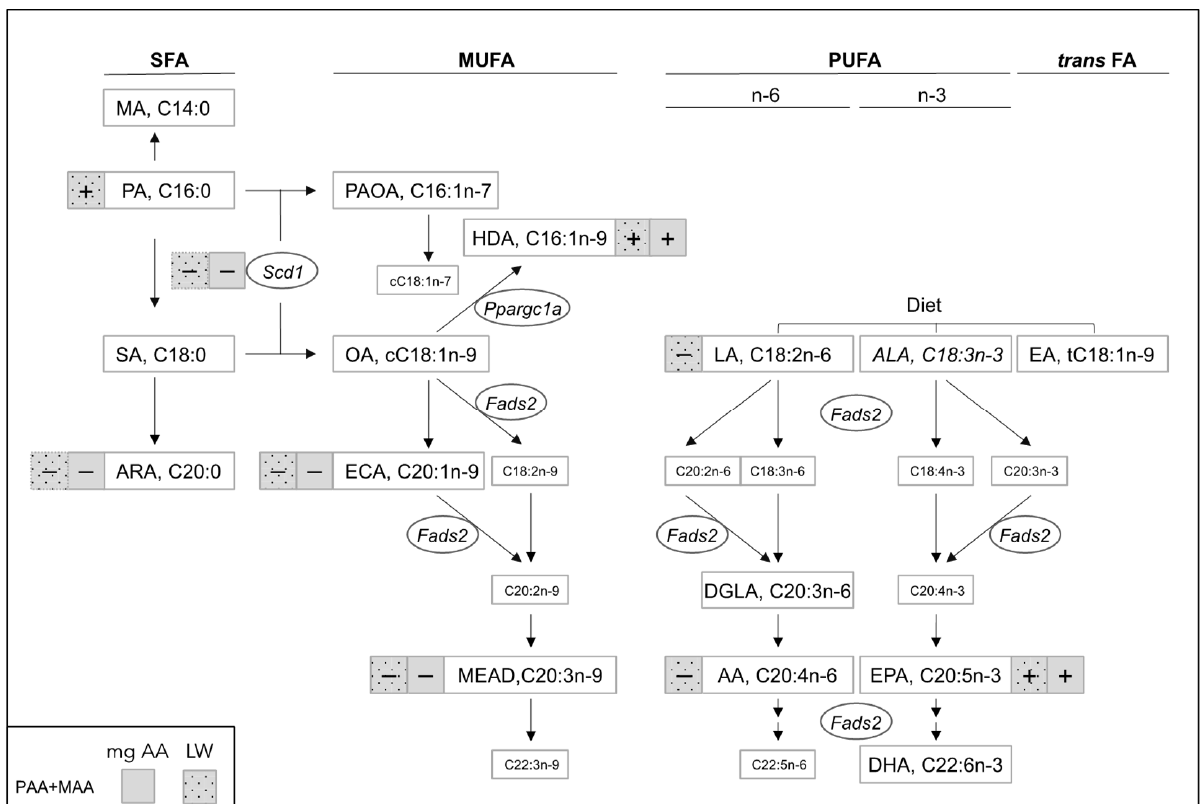
Figure 5. Correlations between milligrams of parental AA exposure or liver weight and offspring liver FA content. Diagram of SFA, MUFA, and PUFA biosynthesis pathways highlighting individual FA that showed significant ( p < 0.05) or borderline significant ( p < 0.1) correlations with both germline and germline + somatic PAA+MAA exposure (Pearson’s r). Large white boxes indicate the analyzed FA; FA in italics were not detectable. Squares with solid and dotted filling indicate significant and borderline significant correlations with AA exposure (grey) or liver weight (grey with black dots); “+” and “ − “ indicate positive and negative correlations, respectively; promoter methylation was analyzed on the genes indicated in ovals; other abbreviations: SFA, MUFA, and PUFA, saturated, mono-, and polyunsaturated FA, respectively; MA, myristic acid; PA, palmitic acid; SA, stearic acid; ARA, arachidic acid; PAOA, palmitoleic acid; OA, oleic acid; ECA, eicosanoic acid; HDA, cis-7-hexadecenoic acid; LA, linoleic acid; ALA, alpha-linolenic acid; EA, elaidic acid; AA, arachidonic acid; EPA, eicosapentaenoic acid; DHA, docosahexaenoic acid; DGLA, dihomo- γ -linolenic acid; Fads2, fatty acid desaturase 2; Scd1, stearoyl-CoA desaturase 1.